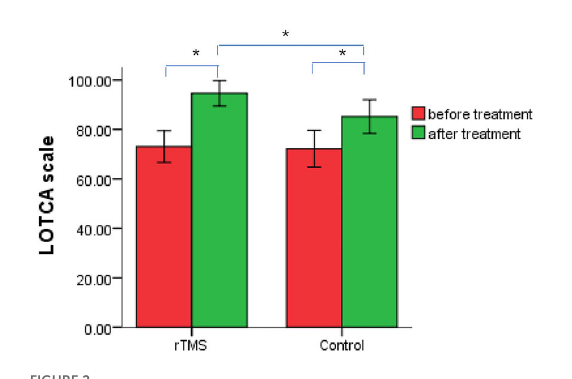
FIGURE2 Changes in loewenstein occupational therapy cognitive assessment scores in treatment and control groups of post-stroke cognitive impairment patients, before and after repetitive transcranial magnetic stimulation therapy. * P <